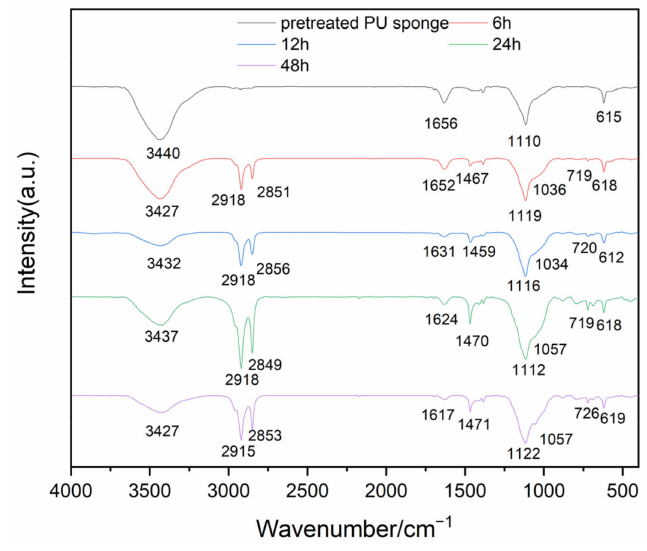
Figure 4. FT-IR spectra of OTS-CNTs/PU sponge with different coupling times.